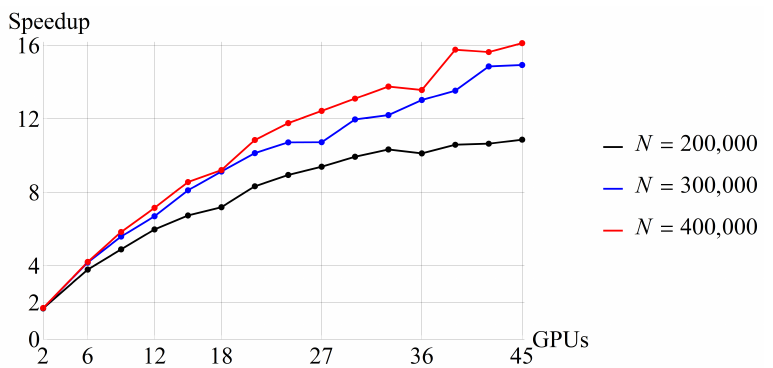
Figure 23. Speedup for different number of Tesla C2050 GPUs (horizontal axis); N is the average number of vortex particles in the wake.